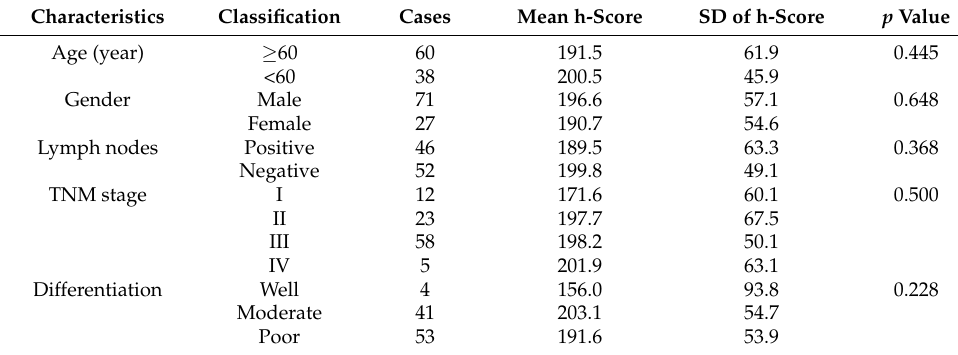
Table 1. The basic characteristics of ESCC